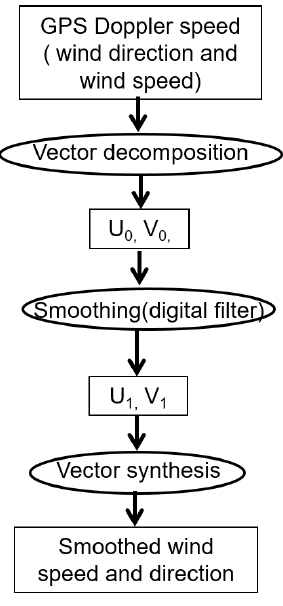
Figure 5. GRUAN data processing flow for RS-11G horizontal wind measurement (Kizu et al., 2018). U 0 and V 0 are uncorrected zonal wind and meridional wind, respectively, U 1 is smoothed zonal wind, and V 1 is smoothed meridional wind. The different shaped boxes indicate as per Fig.